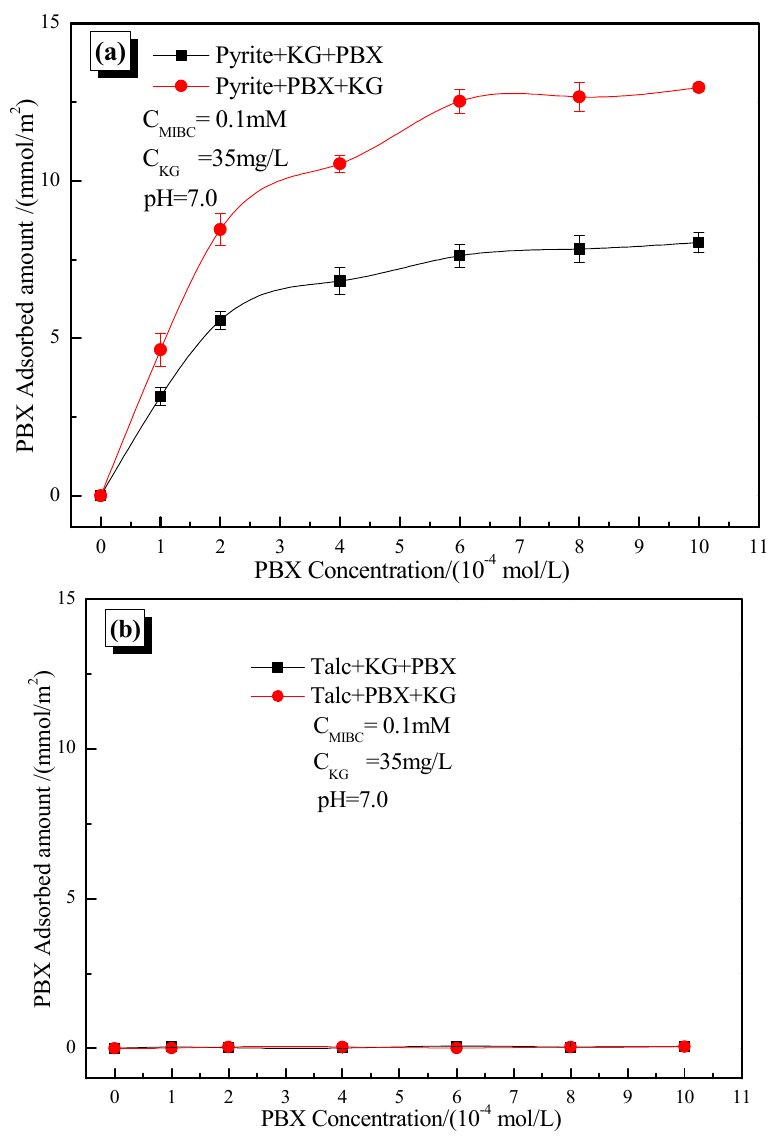
Figure 8. Effect of the KG/PBX addition order on the adsorption of PBX on pyrite ( a ) and talc ( b ).